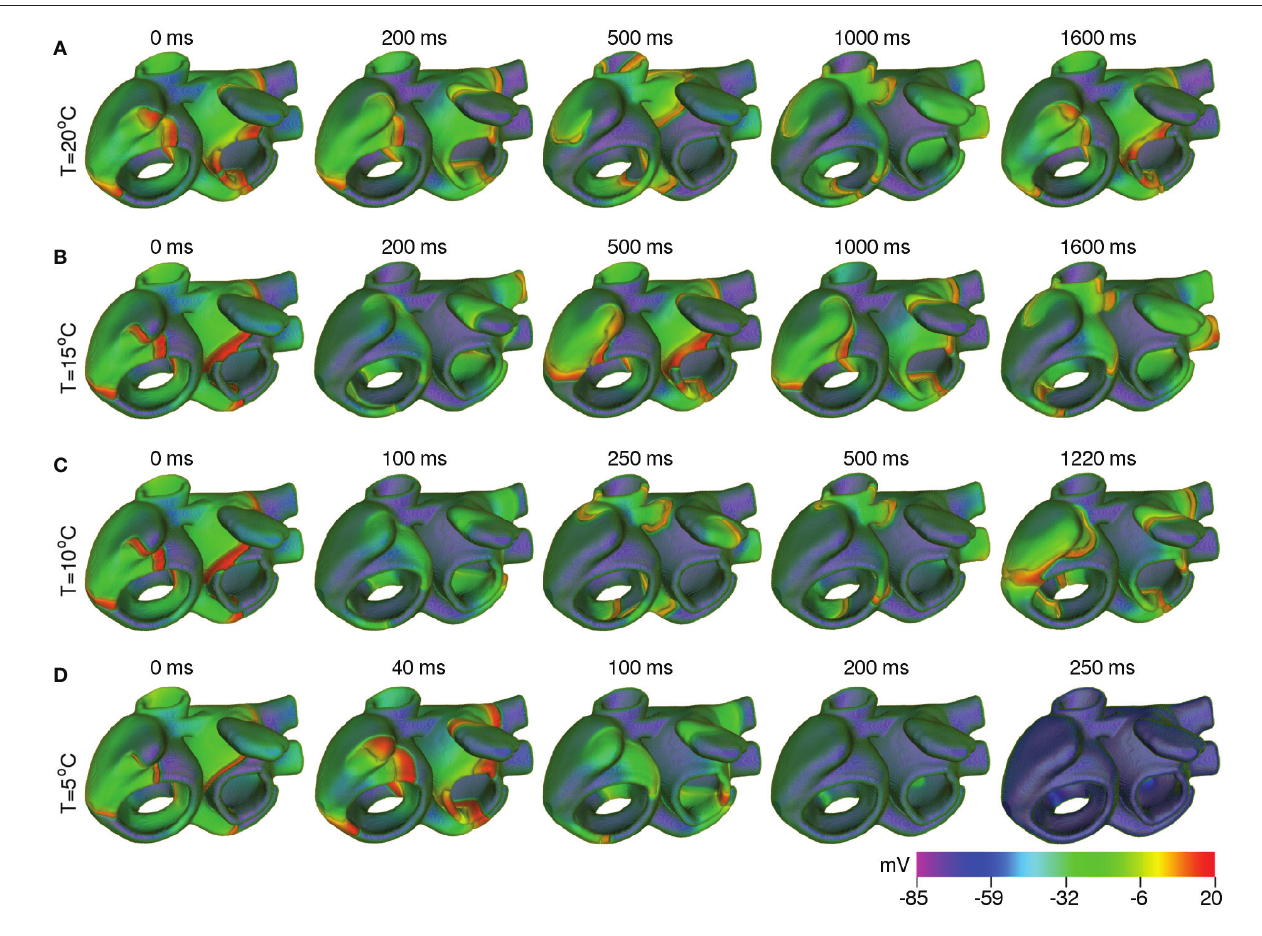
FIGURE 10 | Scroll wave dynamics in the remodeled human atria, under the effect of global cooling at temperatures (A) 20 ◦ C , (B) 15 ◦ C , (C) 10 ◦ C , and (D) 5 ◦ C . Moderate cooling (15 − 20 ◦ C ) leads to stabilization of the initial scroll wave, with reduced period. At ∼ 10 ◦ C , the scroll wave breaks up. The atria then supports multiple scroll waves that maintain a state of sustained AF. Severe cooling ( ∼ 5 ◦ C ) leads to suppression of the scroll wave, within 200